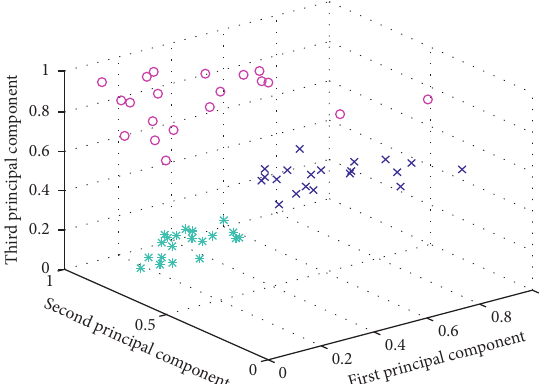
Figure 8: Recognition rate (100%) of test